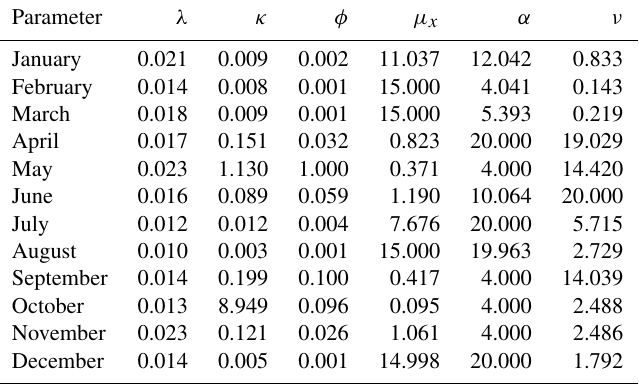
Figure 6. Comparison between the probability density functions of the monthly mean T of the observed and simulated values: Uccle is in red and the ensemble of 50 time series simulated using the C-vine copula V T Table 3. Optimal parameter set for the (monthly) MBL (modified Bartlett–Lewis)